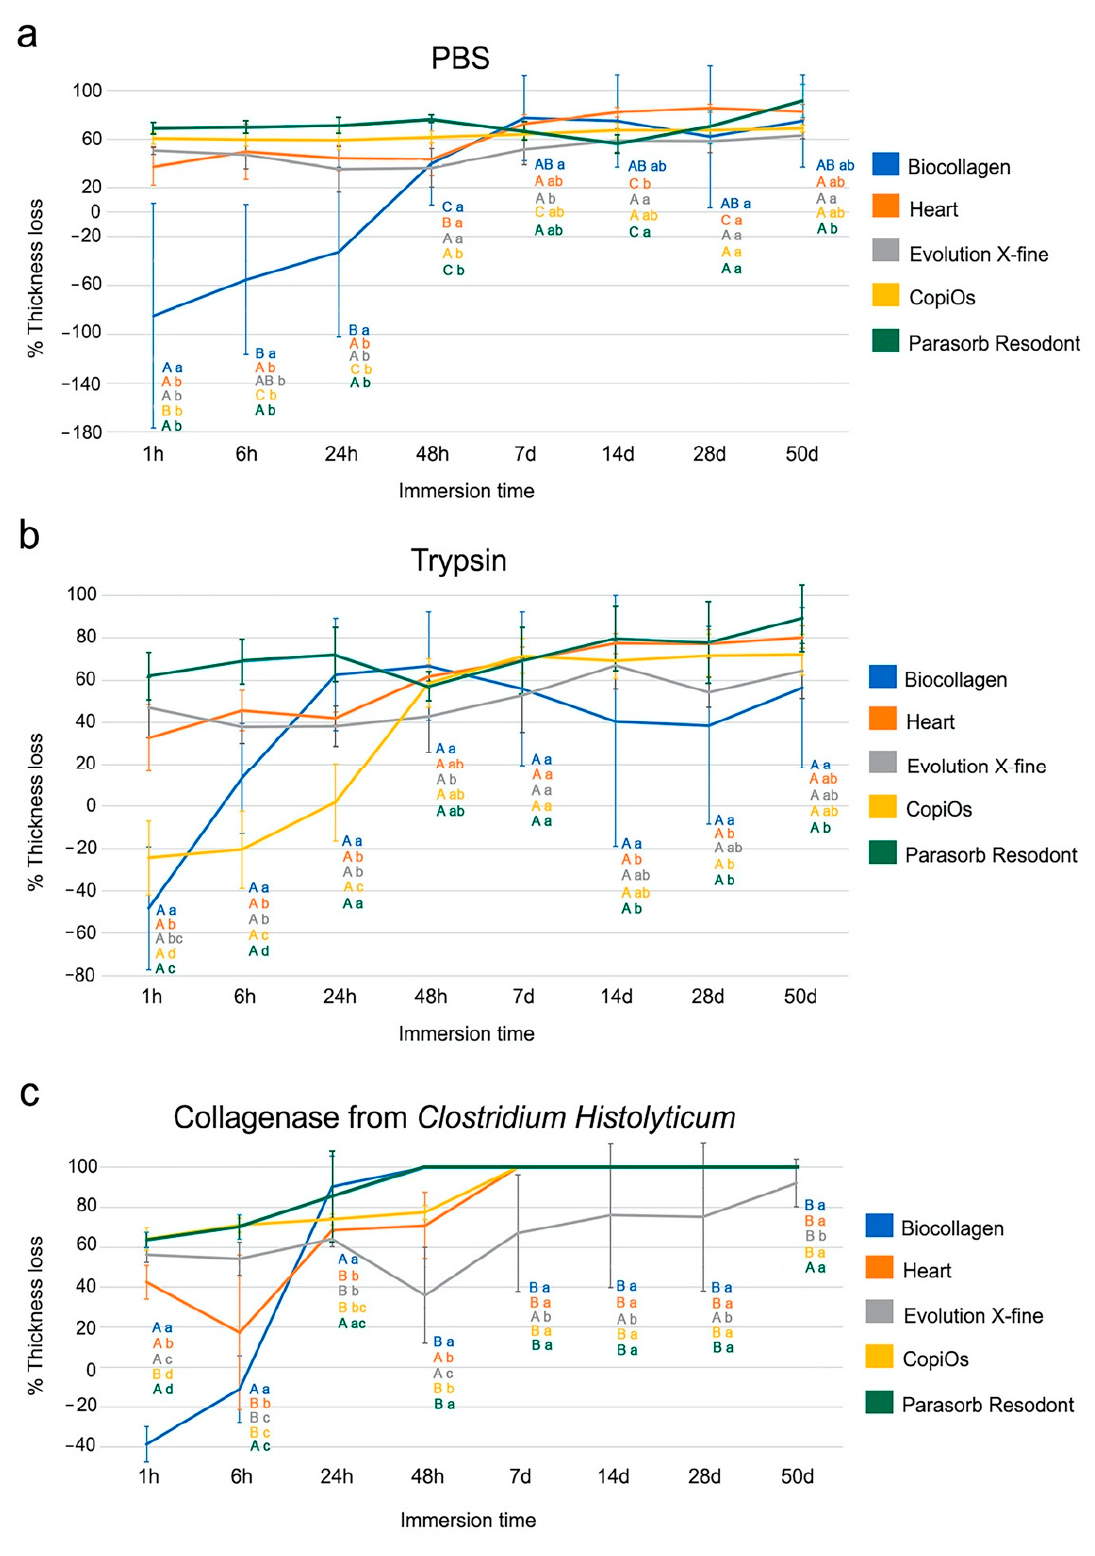
Figure 1. Percentage of thickness loss of the five tested membranes after being submitted to ( a ) PBS, ( b ) trypsin and ( c ) C. histolyticum collagenase over the different time-points. Values are expressed as mean and standard deviation. Significant differences among membranes are shown with low-case letters and capital letters indicate differences between the different degradation tests within the same membrane. Student-Newman-Keuls tests were performed for multiple comparisons ( p < 0.05).